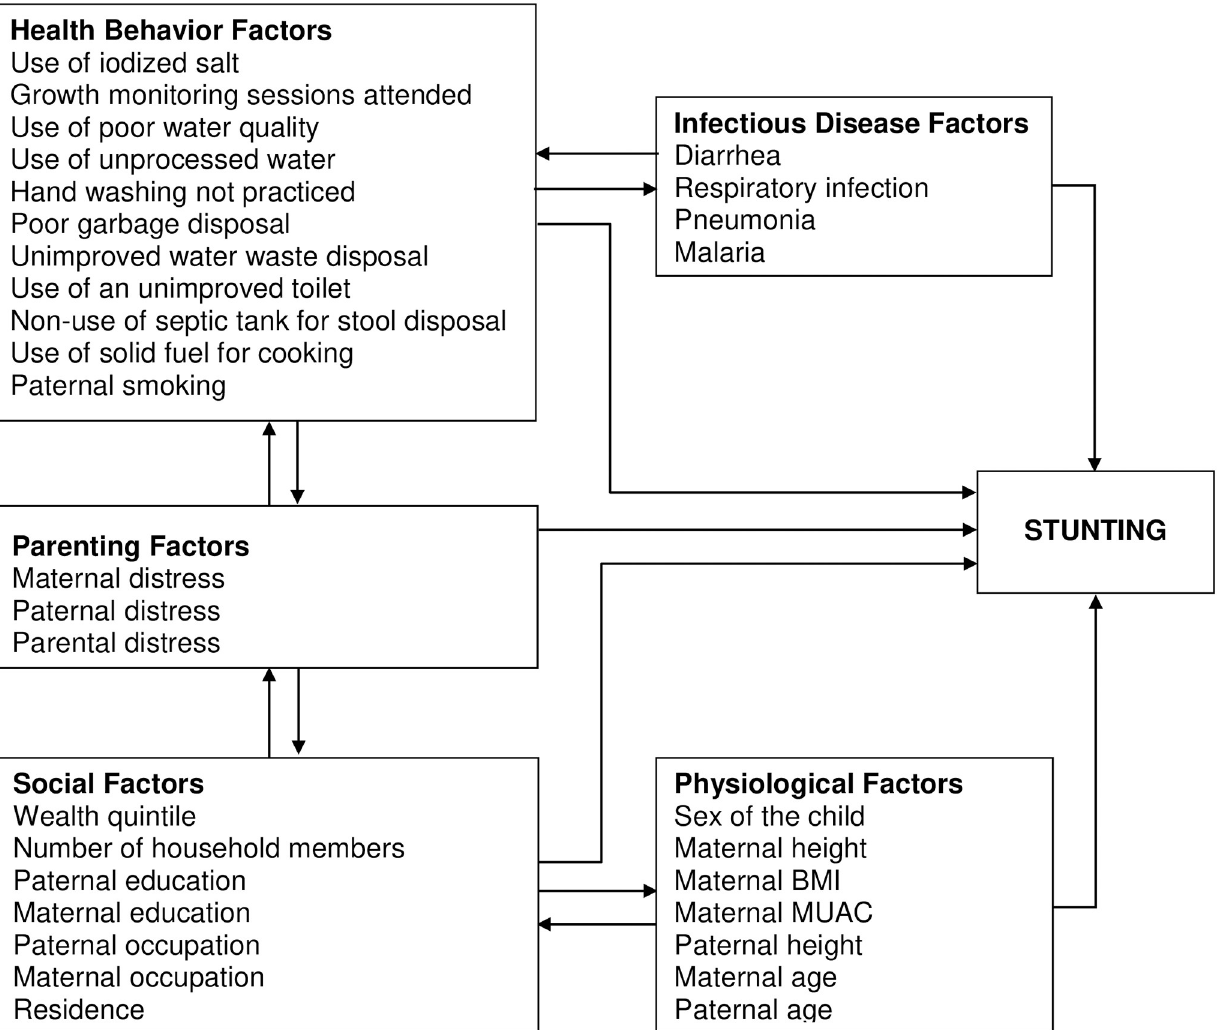
Fig 1. Conceptual framework of the impact of distress of parents and other factors on child stunting. The various groups of factors interact directly and indirectly with each other and with distress, and indirectly and directly on stunting.